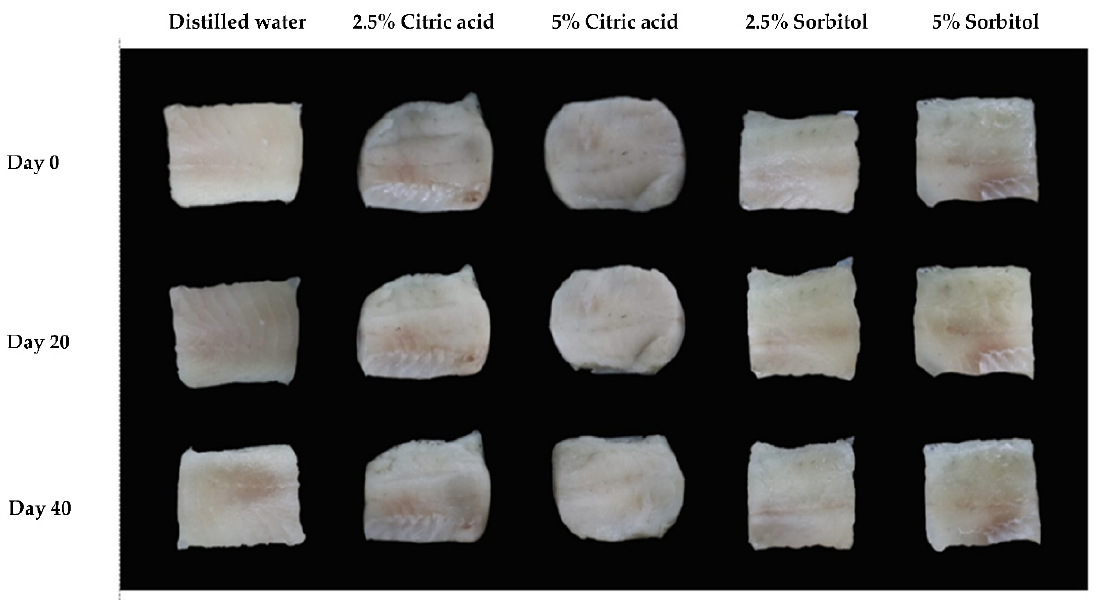
Figure 3. Appearance of frozen fish fillets soaked with different solutions after thawing during frozen storage times. 3.6. Effect of Sorbitol and Citric Acid Solutions on Texture Properties of Frozen Fish Fillets Frozen fish fillets were thawed and analyzed the texture properties as shown in Figure 4. The average values of hardness, cohesiveness, springiness, and gumminess displayed significant variations ( p < 0.05) among different treatments. Hardness of thawed fish fillets soaked with citric acid were increased during storage time. Frozen fish fillets soaked with 2.5% citric acid increased from 97.80 ± 16.68 N (day 0) to 152.28 ± 12.98 N (day 40). Thawed fish fillets soaked with 5% citric acid solution had the highest hardness values ( p < 0.05) at 226.97 ± 40.16 N. It may be the moisture and greater drip losses of the samples that affected the hardness. Hardness of thawed fish fillets decreased, whereas the liquid loss increased. A low pH was directly related to the loss of texture due to the increase in proton concentration [6,7,9], leading to the weakening of connective tissue and protein denaturation [26]. Citric acid solution increased the hardness and gumminess of restructured fish meat related with the decrease of springiness in thawed fish fillets soaked with citric acid. Frozen fish fillets soaked with citric acid had a low pH (4.35–5.56). The pH values were close to the isoelectric point of fish proteins (pH = 5.5) [37], leading to increase hardness and gumminess. Texture properties of thawed fish fillets soaked with sorbitol were not significantly different compared to the control sample. In addition, there were no significant differences in cohesiveness ( p > 0.05) among samples.